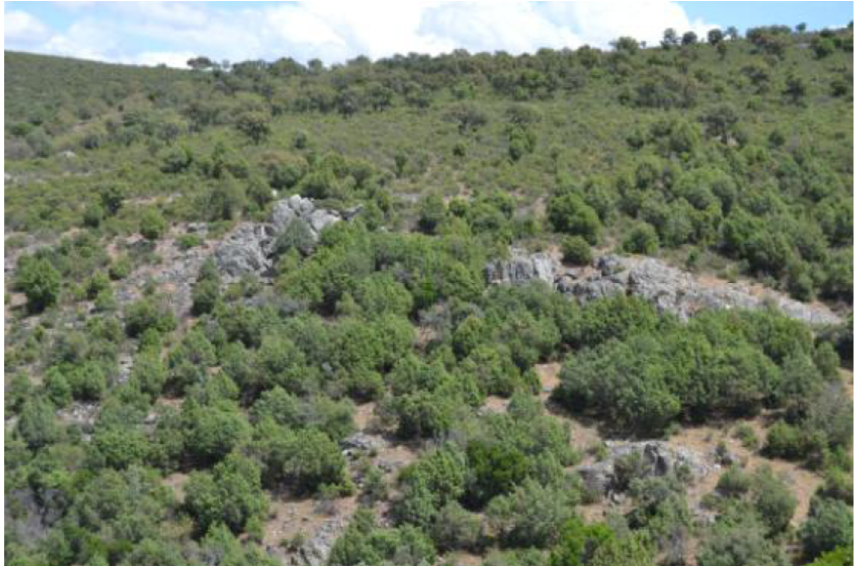
Figure 18. Juniperion badiae.